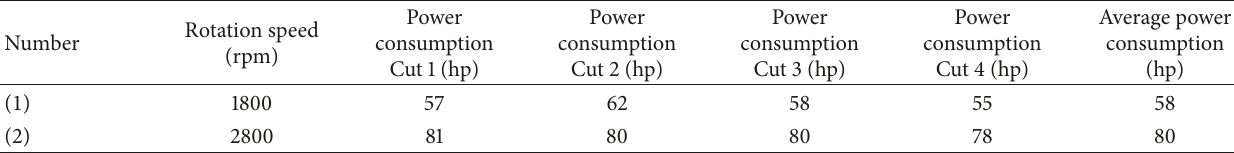
Table 2: Mean value of power consumption during sutting.